Question: Sum up the contents of this chart in one sentence.
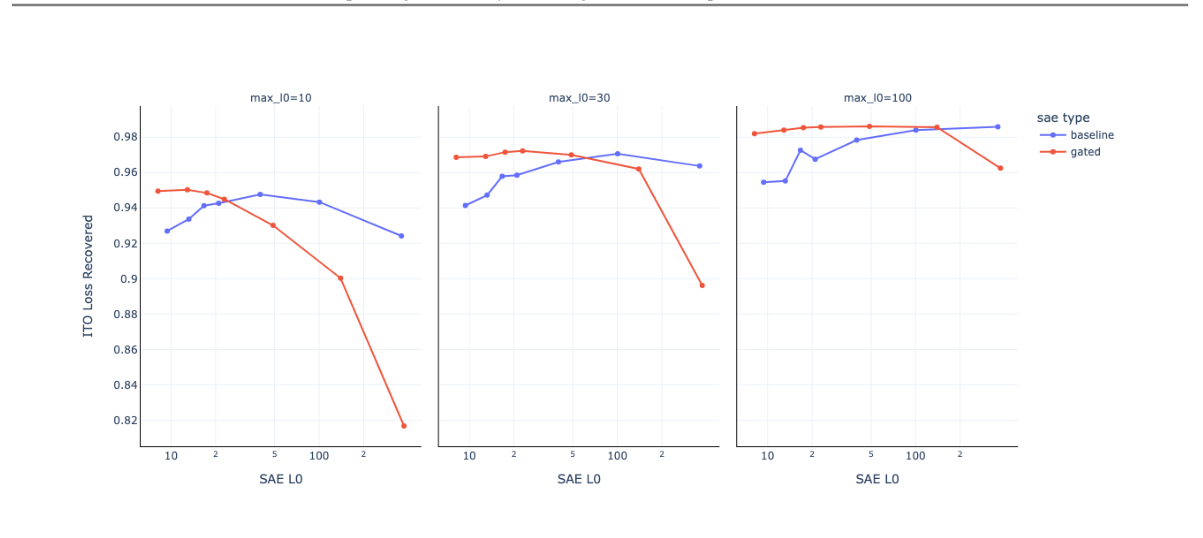
Answer: | This figure compares the ITO performance of different decoders across a sweep for decoders trained using a baseline SAE and the gated method, at three different test time target sparsities. Gated SAEs trained at lower target sparsities consistently achieve better dictionaries by this measure. Interestingly, the best performing baseline dictionary by this measure often has a much higher test time sparsity than the target; for instance, at a test time sparsity of 30, the best baseline SAE was the one that had a test time sparsity of more like 100. This could be an artifact of the fact that the L0 measure is quite sensitive to noise, and standard SAE architectures tend to have a reasonable number of features with very low activation.